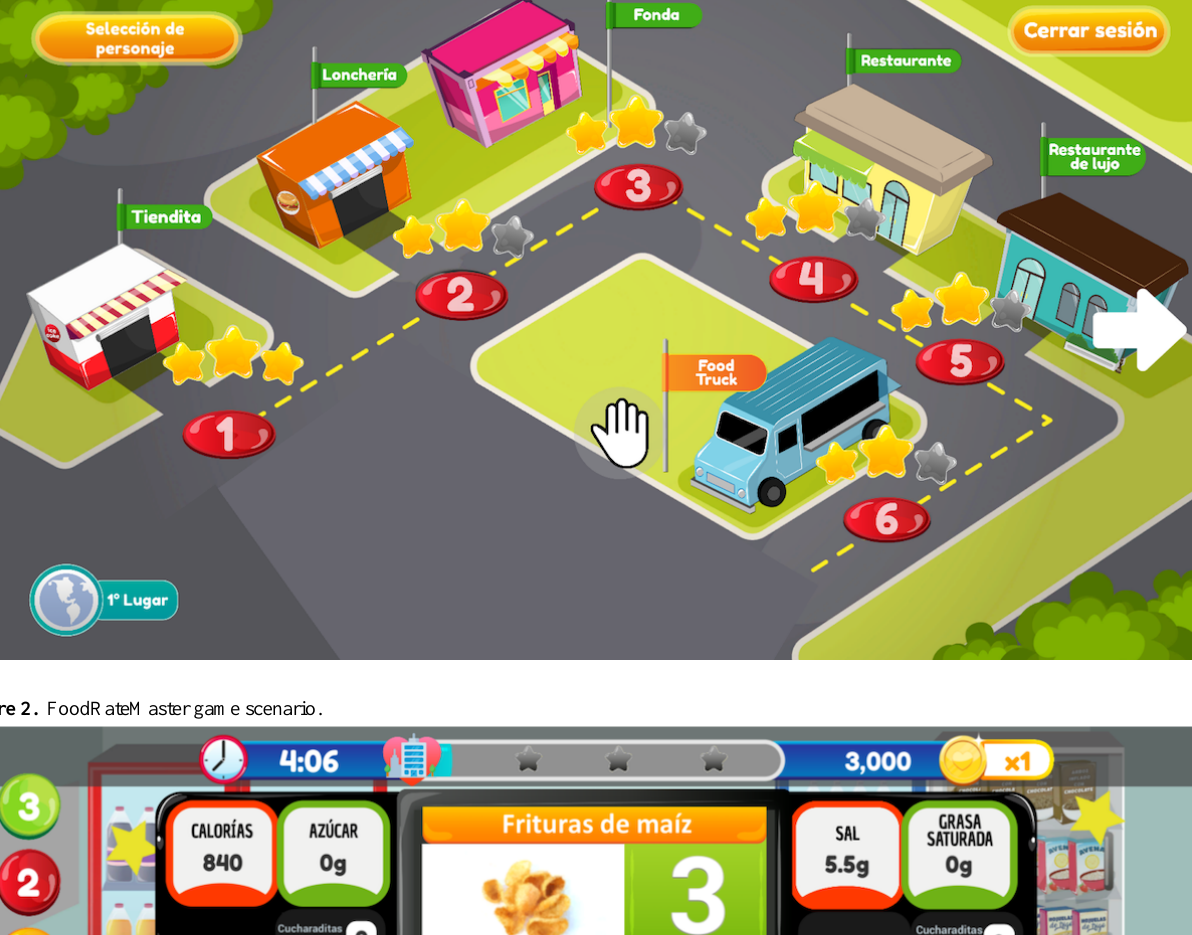
Figure 1. FoodRateMaster scenario map.